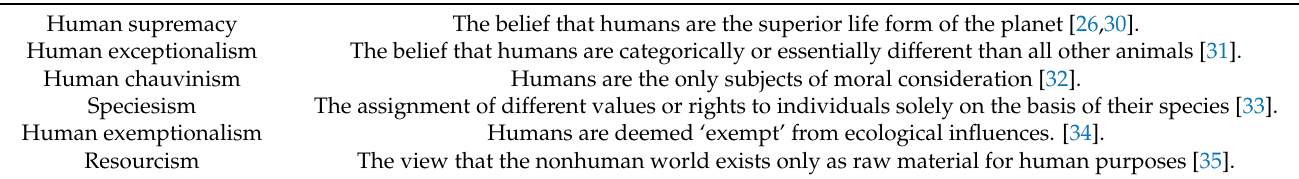
Table 1. Terms affiliated with anthropocentrism.